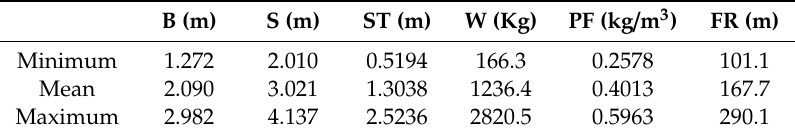
Table 1. Details of the parameters of blasting work in this